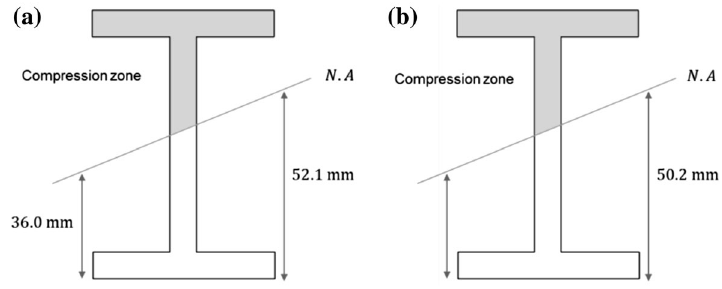
Fig. 17 Compression zones for the a ST1 and b ST2 beams at the critical